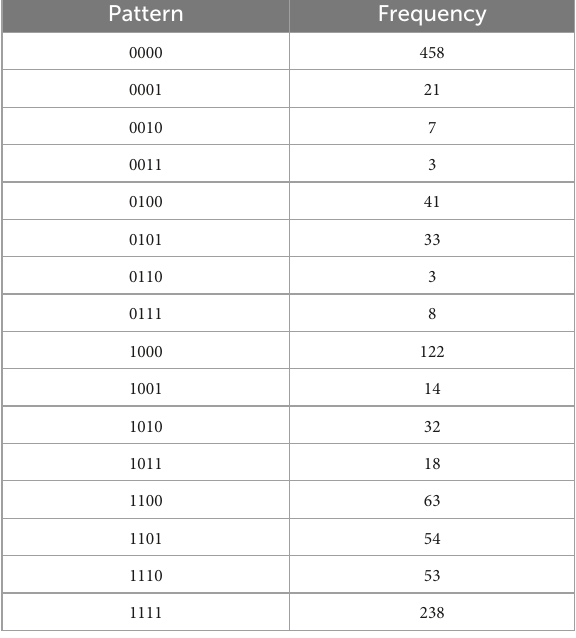
TABLE 4D Introjected regulation, with N = 1168, k = 4 items, and u = 16 unique response patterns ( Appendix B ).